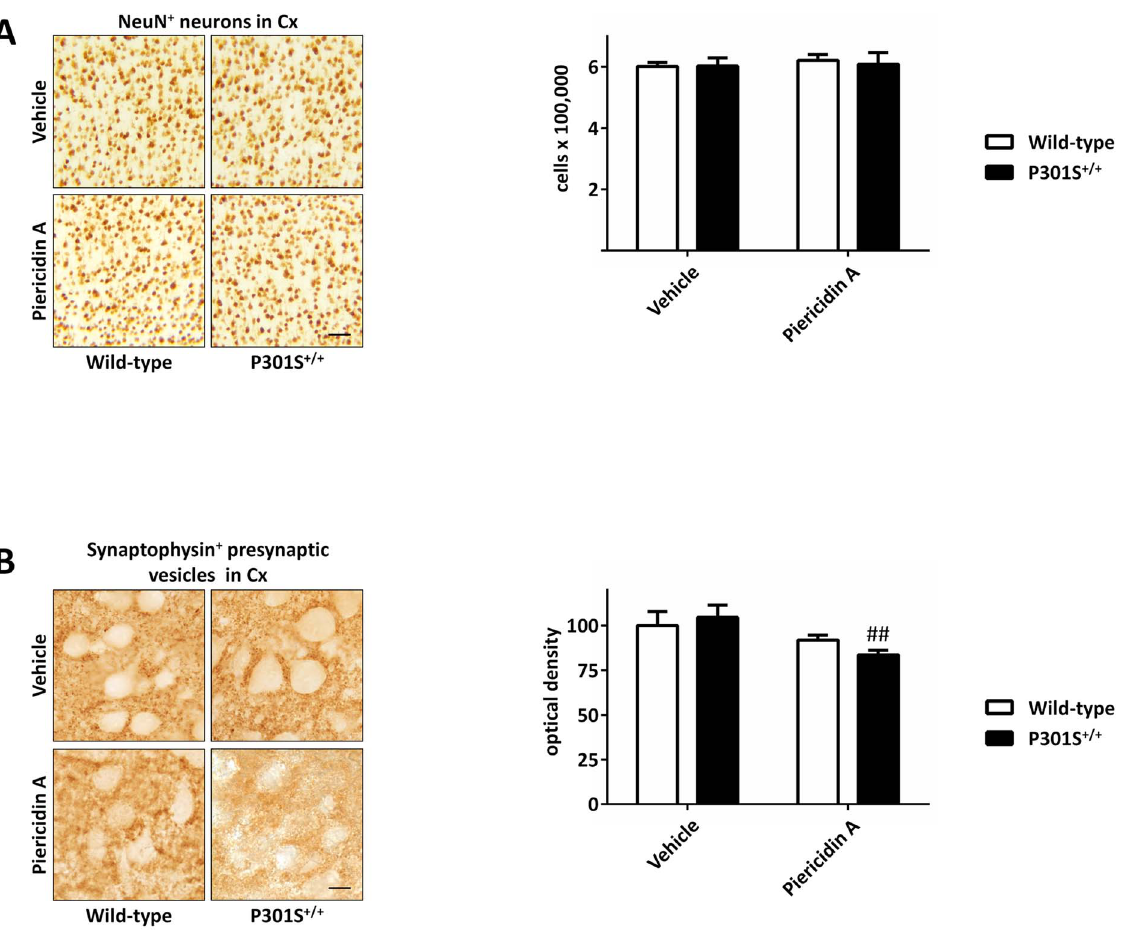
Figure 2. Effects of piericidin A treatment on neuronal cell count and synaptic density. A: Neuronal nuclei (NeuN)-stained sections of the frontal cortex (Cx) of wild-type and P301S + / + mice treated with vehicle or piericidin A (left panel). Quantification of NeuN immunoreactive cells in the cortex showed no difference in the four animal groups (right panel). Scale bar 50 m m. B: Sections of the frontal cortex stained with an antibody against synaptophysin as marker for the synaptic density (left panel). The immunoreactivity quantified by optical density measurement was significantly reduced in piericidin A treated P301S + / + mice compared to vehicle treated P301S + / + (right panel). Scale bar: 10 m m. ## p , 0.01, piericidin A treatment vs vehicle treatment at the same genotype. Two-way ANOVA with Fisher LSD post-hoc